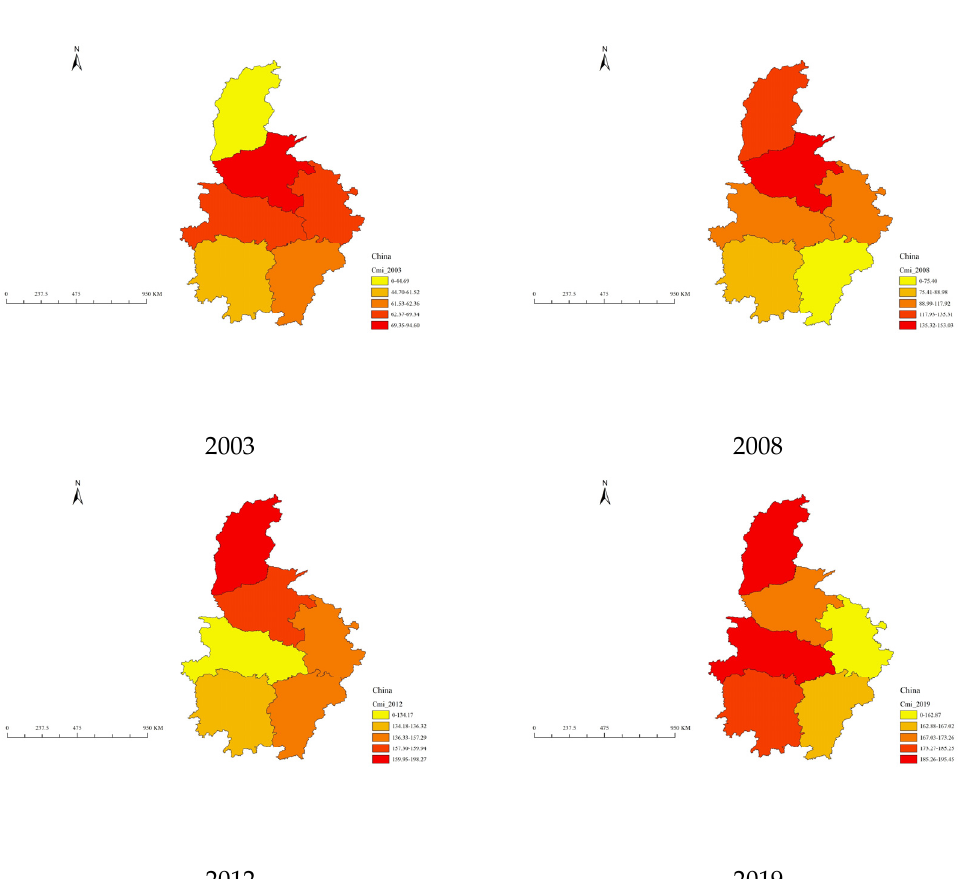
Figure 3. The level of market integration in central China.